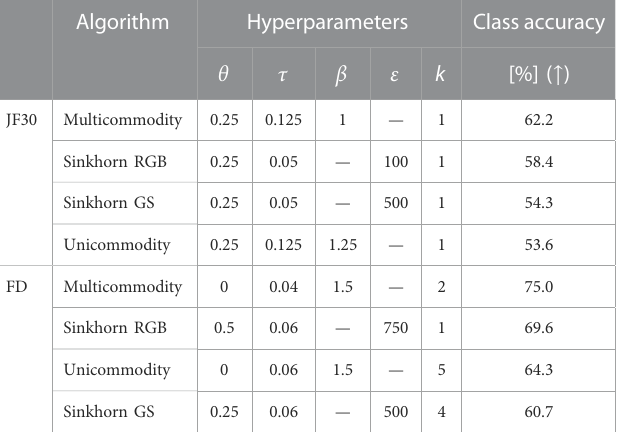
performance is achieved with distributed transport paths, i.e., lower β (see Supplementary Material).